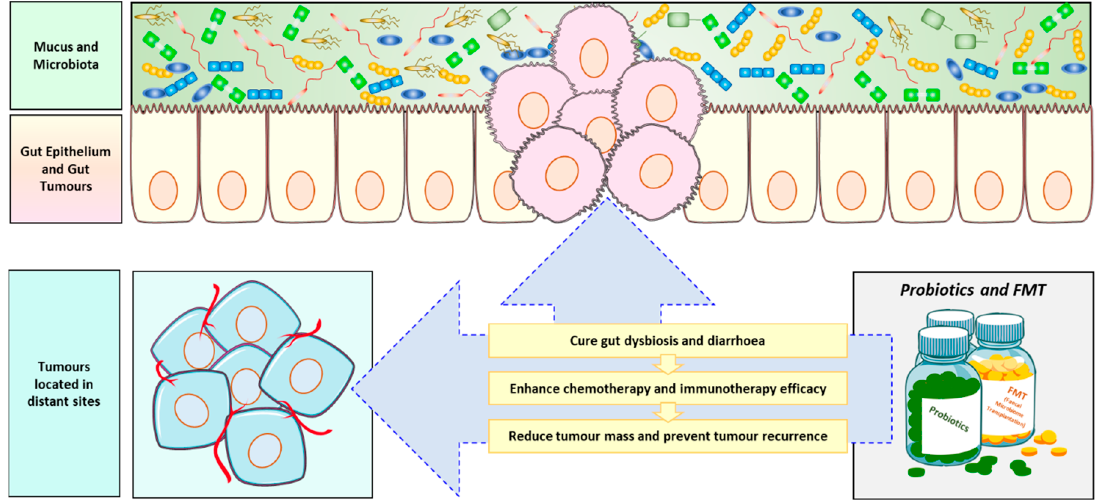
Figure 3. Role of probiotics in anti-cancer therapy. Probiotics and Fecal Microbiome Transplantation (FMT) are currently studied as anti-cancer adjuvants to fight dysbiosis following anti-cancer therapy, to increase chemotherapy and immunotherapy efficacy and to both reduce tumor mass and prevent tumor recurrence.